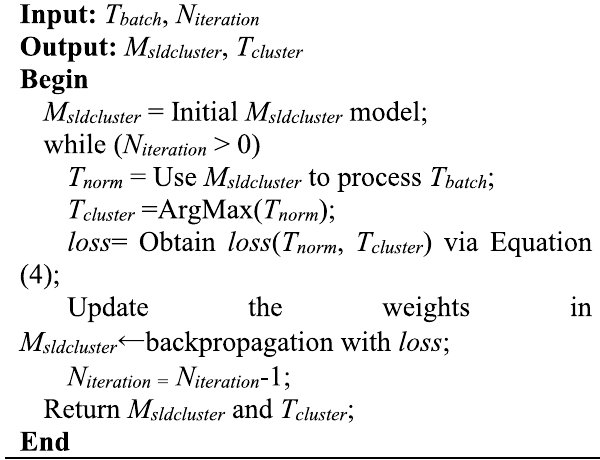
Algorithm 2. SLD relationship extraction (SLD-E) algorithm.